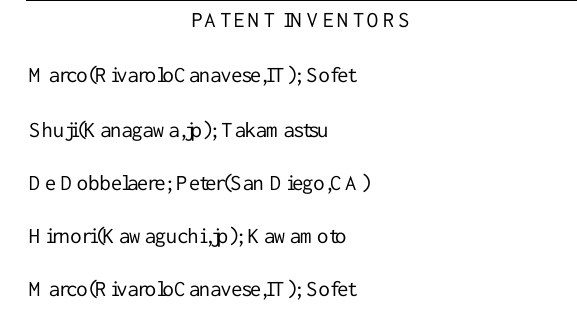
Table 2. Token wise field